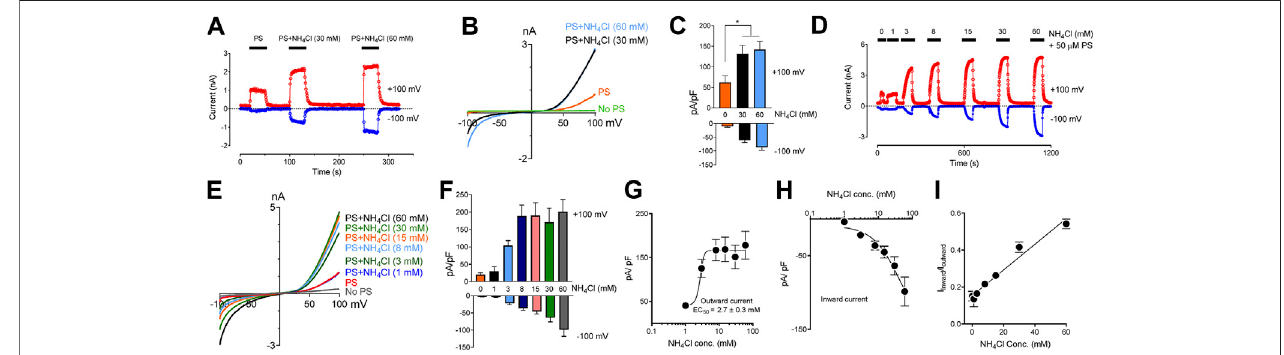
FIGURE 4 | Inhibitory effect of low intracellular pH on TRPM3 can be reversed by perfusing cells with extracellular solution containing NH 4 Cl. (A) Time course showing outward and inward current, recorded at +100 and − 100 mV respectively, obtained from HEK cells overexpressing TRPM3, under voltage ramp protocol ranging − 100 to +100 mV, (pH i (cid:2) 6.0, n (cid:2) 11 cells). Indicated concentrations of NH 4 Cl was applied extracellularly along with PS. To achieve similar osmolarity, all extracellular Na + concentration was lowered to 85 mM and osmolarities were adjusted to 300 ± 10 mOsm by mannitol. Adequate washing time (1 – 3 min) was providedaftereachapplicationofNH 4 Cl,tobringthecurrentdowntothebasallevel,whichis6.0forallthecellsrecorded.Representativecurrentwasplottedvs.timein the presence of extracellular NH 4 Cl and PS, at the indicated concentrations. To achieve similar osmolarity, all extracellular buffer Na + concentration was lowered to 85 mM and osmolarities were adjusted to 300 ± 10 mOsm by mannitol. (B) Representative recording of TRPM3 current by ramp protocols ranging from − 100 mV to +100 mV at the indicated NH 4 Cl concentrations. (C) Mean outward and inward TRPM3 current at the indicated NH 4 Cl concentrations (mean ± SEM, n (cid:2) 11 cells). * indicates p < 0.05byunpairedStudent ’ st-test. (D) RepresentativerecordingofTRPM3currentbythedose-dependenteffectsofNH 4 Cl.Theapplicationsofextracellular NH 4 Cl at the indicated concentrations. (E) Representative recording of TRPM3 current by ramp protocols ranging from − 100 mV to +100 mV at the indicated NH 4 Cl concentration. (Frompanel d) (F) MeanoutwardandinwardTRPM3currentat theindicatedNH 4 Cl concentration.(From replicated experimentof (D) )(mean ± SEM, n (cid:2) 11 cells). (G,H) Concentration-dependence curves of effects of NH 4 Cl on TRPM3 activations, outward (G) and inward (H) currents, respectively. All currents were normalized to the corresponding capacitance of the cell overexpressing hTRPM3 (mean ± SEM, n (cid:2) 11 cells) at the indicated NH 4 Cl concentration. EC 50 values were measured separately for outward (NH 4 Cl 50 (cid:2) 2.7 ± 0.3 µM) currents, whereas the inward currents continue to increase after applying 60 mM NH 4 Cl. (I) Mean ratio of inward current to outward current plotted against NH 4 Cl concentrations (mean ± SEM, n (cid:2) 11 cells).